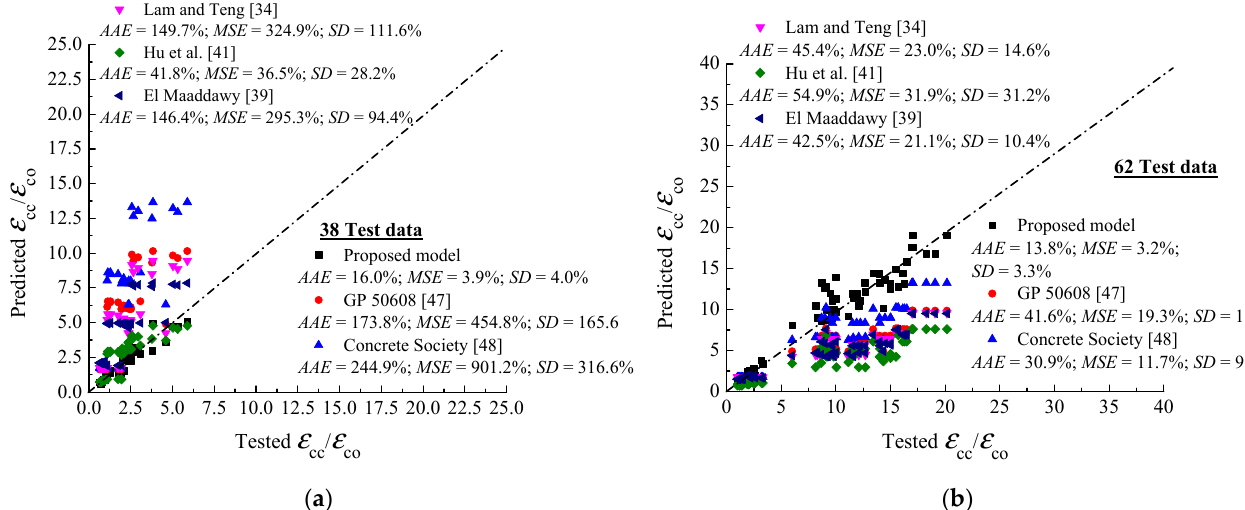
Figure 4. Performance of proposed and existing FRP-confined concrete models of peak strain; ( a ) data recorded on compression and tension zones; ( b ) data recorded on compression zone.